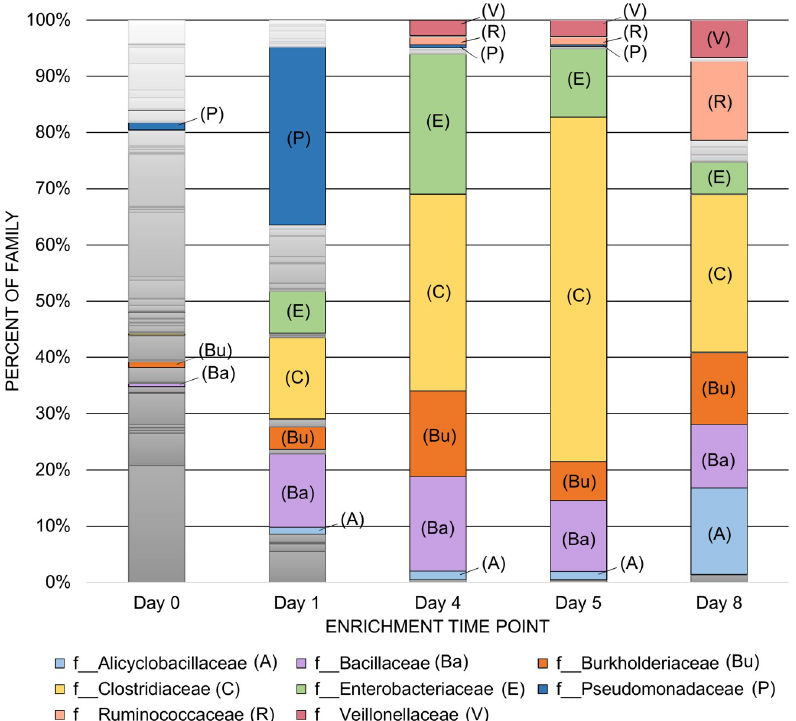
Fig 1. Bacterial community profile across anaerobic syrup enrichment cycles. Reads were averaged from the PCR pools for each of the three replicate reactors across five time points over the eight-day enrichment. Dominant families listed throughout the enrichment are indicated with the following labels: A = Alicyclobacillaceae , Ba = Bacillaceae , Bu = Burkholderiaceae , C = Clostridiaceae , E = Enterobacteriaceae , P = Pseudomonadaceae , R = Ruminococcaceae , and V = Veillonellaceae